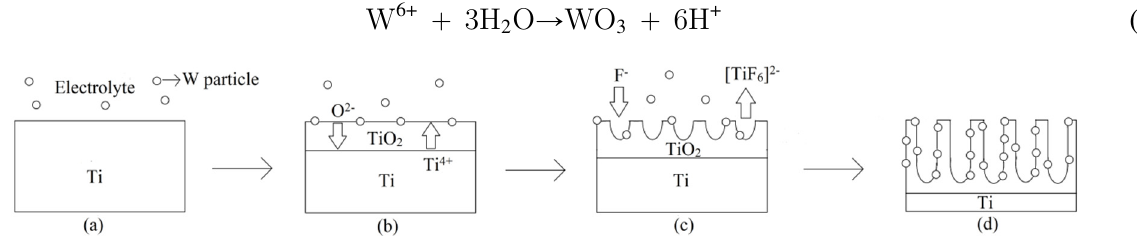
Figure 2. Formation of WO 3 -loaded TiO 2 nanotubes: ( a ) Ti foil, ( b ) oxide layer formation, ( c ) chemical dissolution of oxide layer, and ( d ) WO 3 -loaded TiO 2 nanotubes.